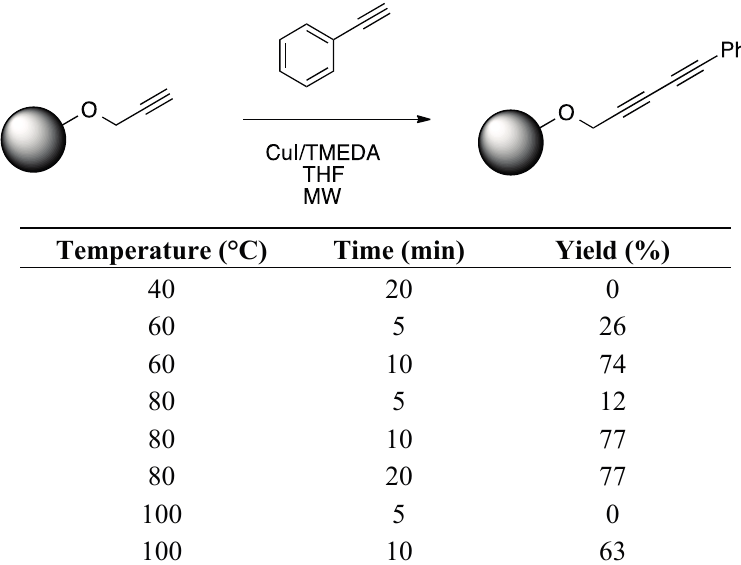
Table 1. Microwave Optimization of the Glaser-Hay